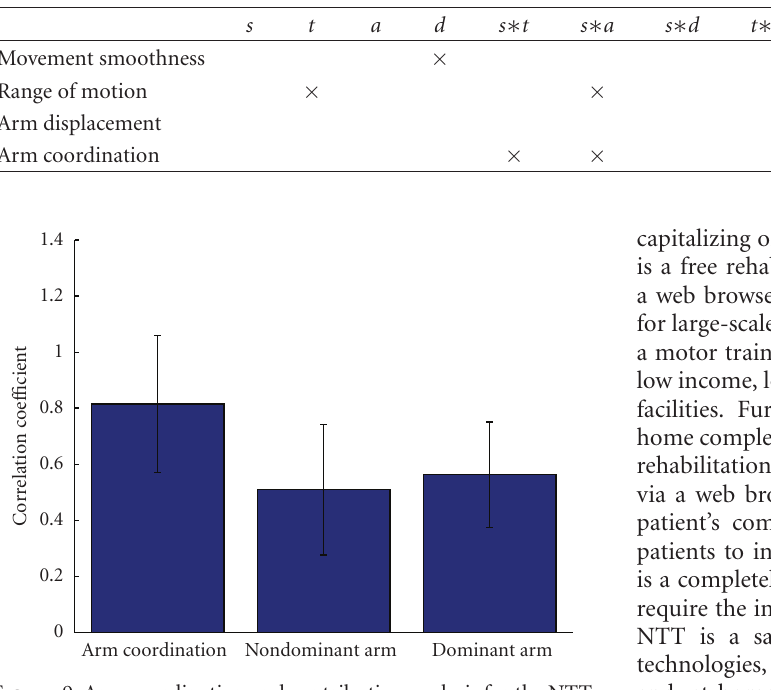
Figure 9: Arm coordination and contribution analysis for the NTT training task. Data from 10 healthy participants. Bars indicate the mean and error bars the